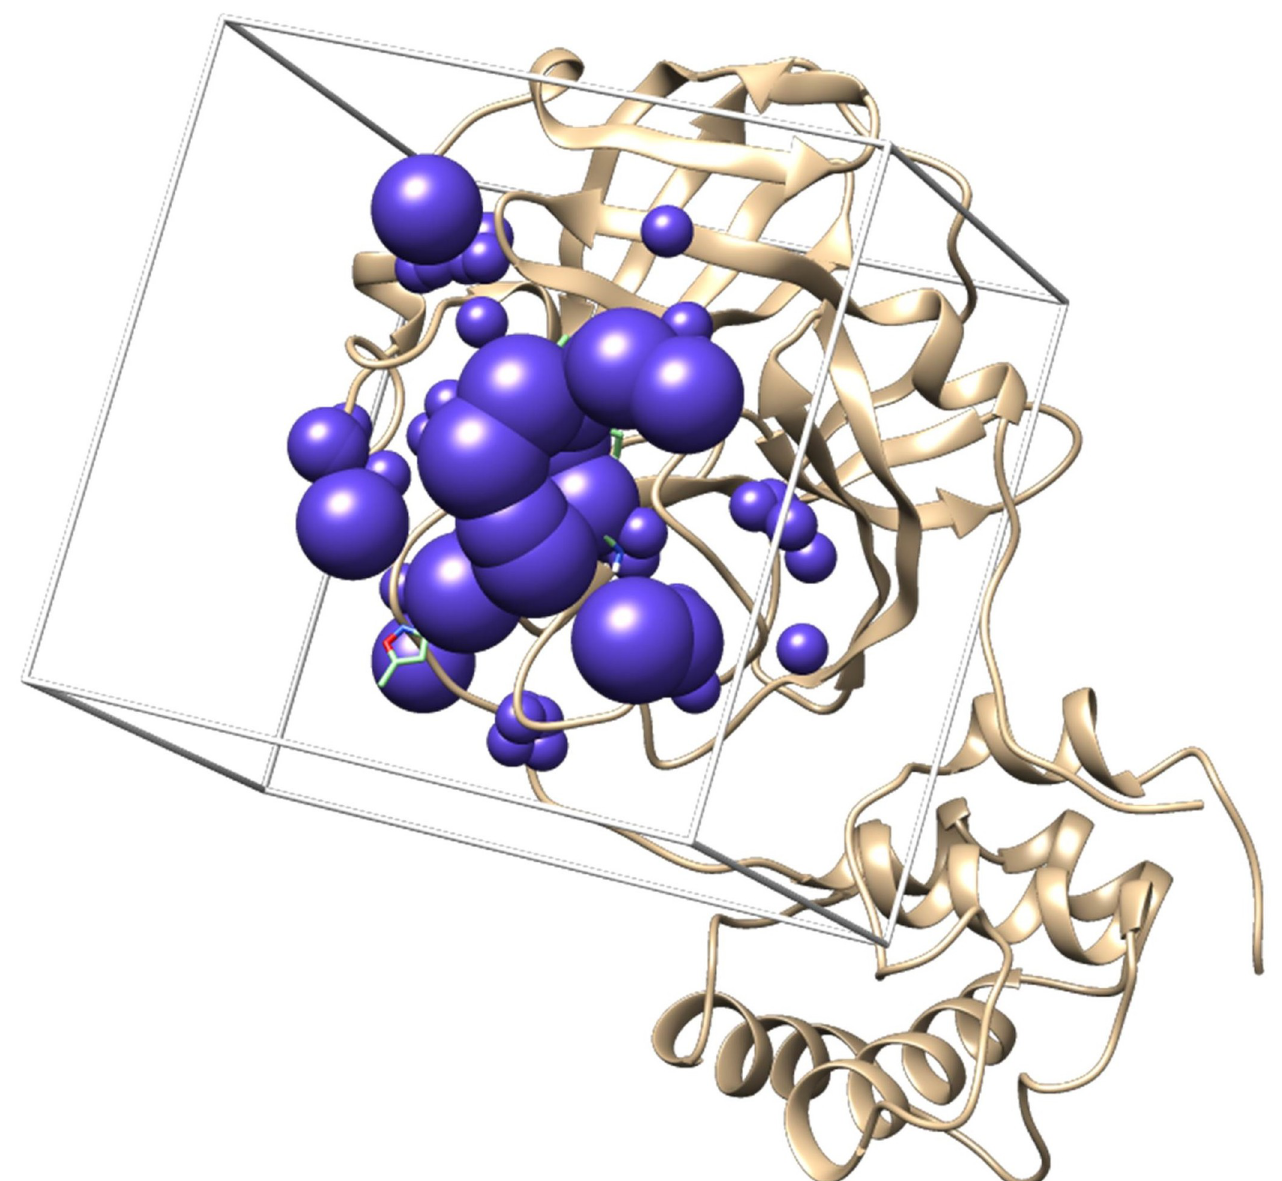
Fig 2. The position of the simulation box, native ligand, and cluster of spheres relative to the receptor.